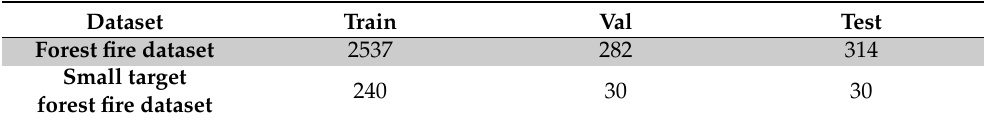
Table 4. Details of the two